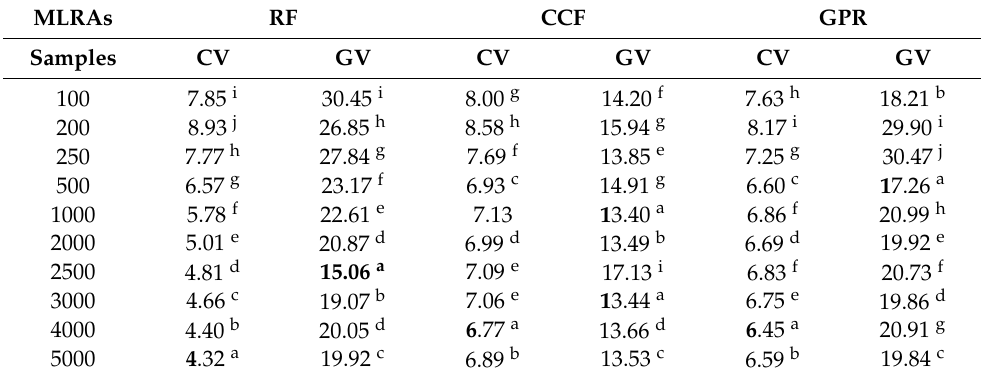
Note : The highlighted numbers indicate the best retrieval; Cv and Gv denote the cross-validation and ground validations; the letters represent the ranking of Friedman’s aligned post-hoc test, there is no significant difference when sharing the same letter. Table A4. Average NRMSE % of 10 replicates, based on cross-validation and ground validation under different sample sizes and machine learning methods, for CCC estimates.